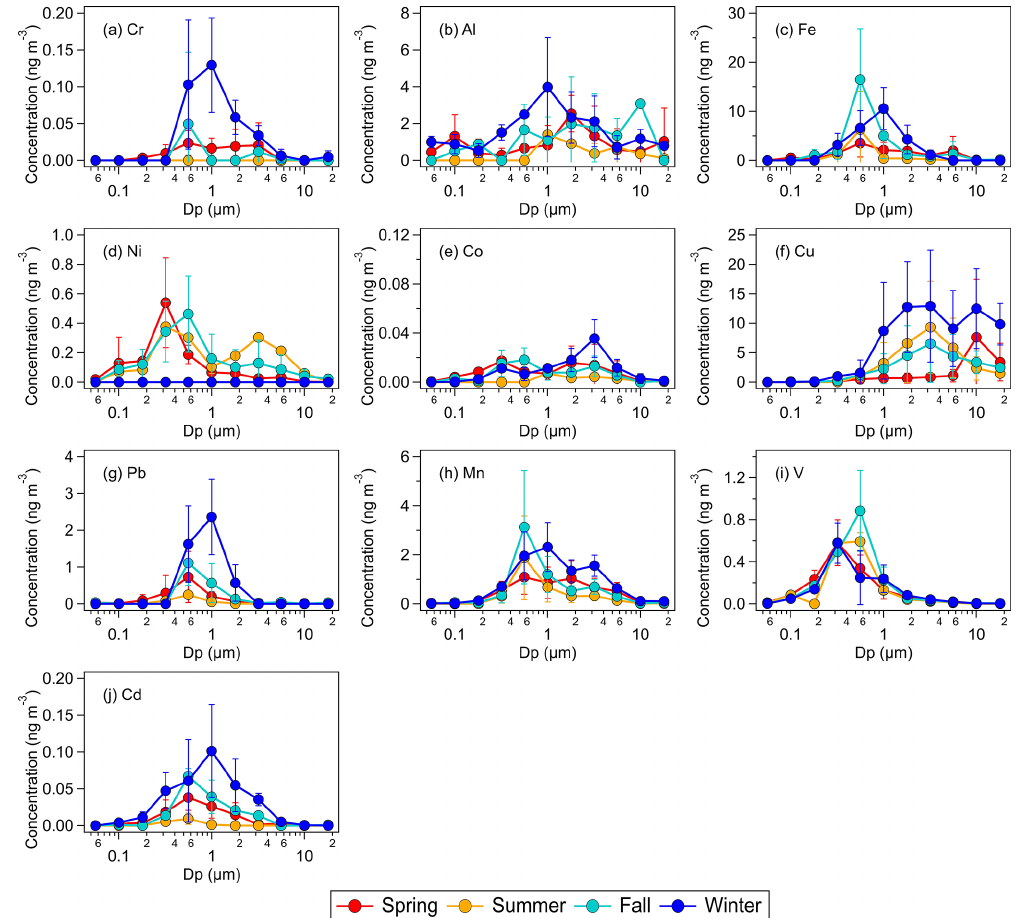
Figure 3. Seasonal average concentrations of water-soluble metals in size-fractionated aerosols sampled by the MOUDI with the following nominal cut points (Dp): 0.056µm (size fraction 1), 0.1µm (size fraction 2), 0.18µm (size fraction 3), 0.32µm (size fraction 4), 0.56µm (size fraction 5), 1.0µm (size fraction 6), 1.8µm (size fraction 7), 3.2µm (size fraction 8), 5.6µm (size fraction 9), 10µm (size fraction 10), and 18µm (size fraction 11). The error bars represent 1 standard deviation of the seasonal average value.